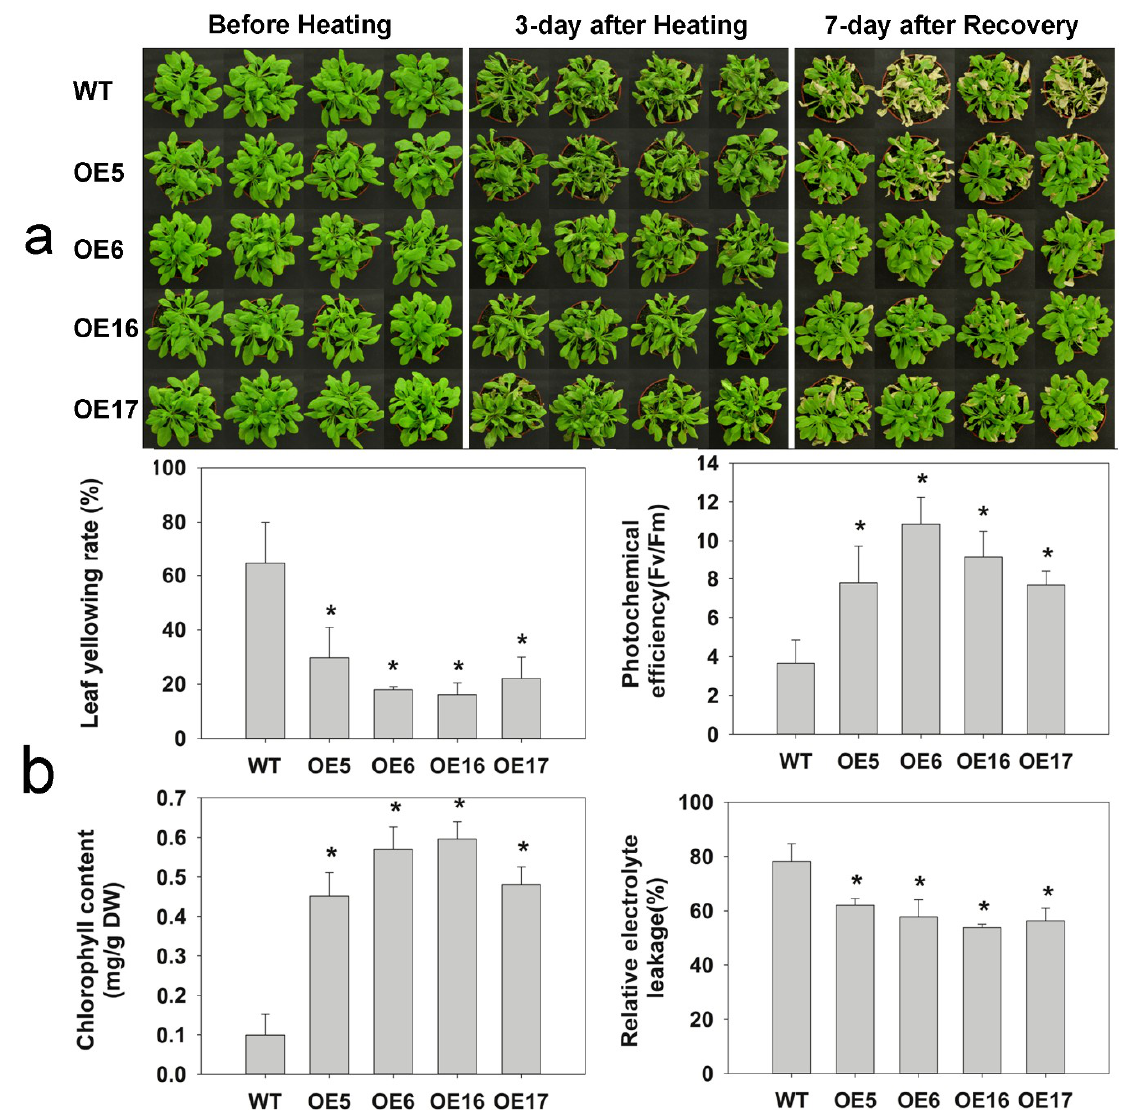
Figure 6. Heat tolerance of FaHsfC1b ‐overexpression Arabidopsis. ( a ) Performance of 6‐week‐old WT and transgenic plants in pots before heat treatment, after heat treatment (12‐h 45 °C/12‐h 40 °C), and after recovery (25 °C). ( b ) Leaf yellowing rate, photochemical efficiency ( F v / F m ), total chlorophyll content (Chl), and relative electrolyte leakage (EL) of plants in Figure 6a after 7 - day recovery. Values were means ± SD of four different biological replications. Asterisks on the top of bars indicated significant differences between WT and transgenic lines according to Fisher’s protected LSD test ( p < 0.05).